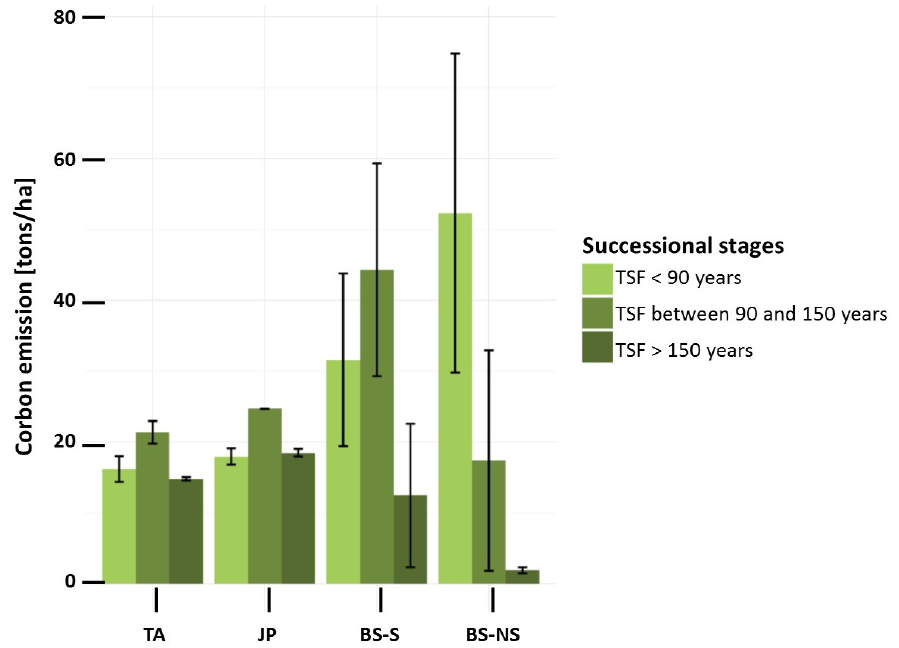
Figure 3. CanFIRE potential carbon emissions averaged by early (TSF < 90 years), intermediate (TSF between 90 and 150 years), and late (TSF > 150 years) successional stages, and by dominant forest types of the Clay Belt boreal landscape (trembling aspen (TA), jack pine (JP), black spruce originating from severe fire (BS-S), and black spruce originating from non-severe fire (BS-NS) forests). Error bars represent the mean standard